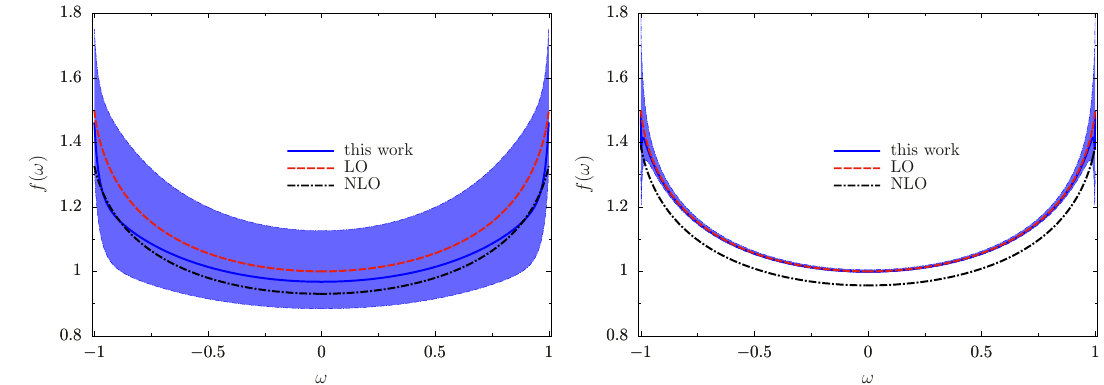
Figure 13. f ( ! ) obtained from the dispersive representation (6.5) (blue solid line with uncertainty band) calculated at Q 2 + Q 2 = 35 GeV 2 (left) and at Q 2 1 2 to f ( ! ) from the LO and NLO asymptotic pion distribution amplitudes (cid:30) (cid:25) ( u ) = 6 u (1 dashed line) and (5.14) (black dot-dashed